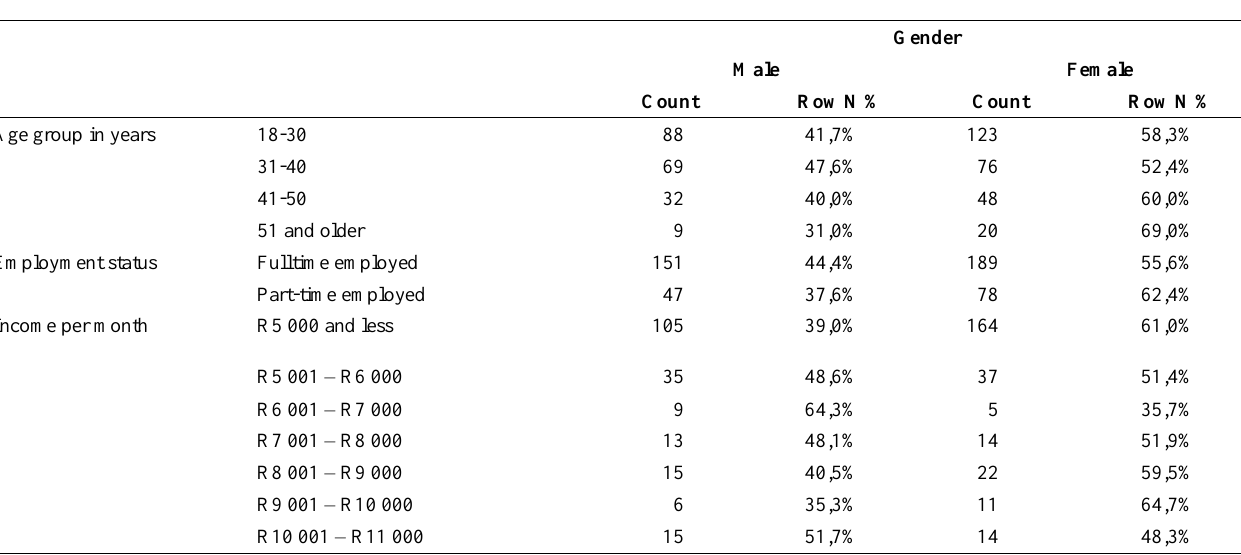
Table 1: Demographics of respondents